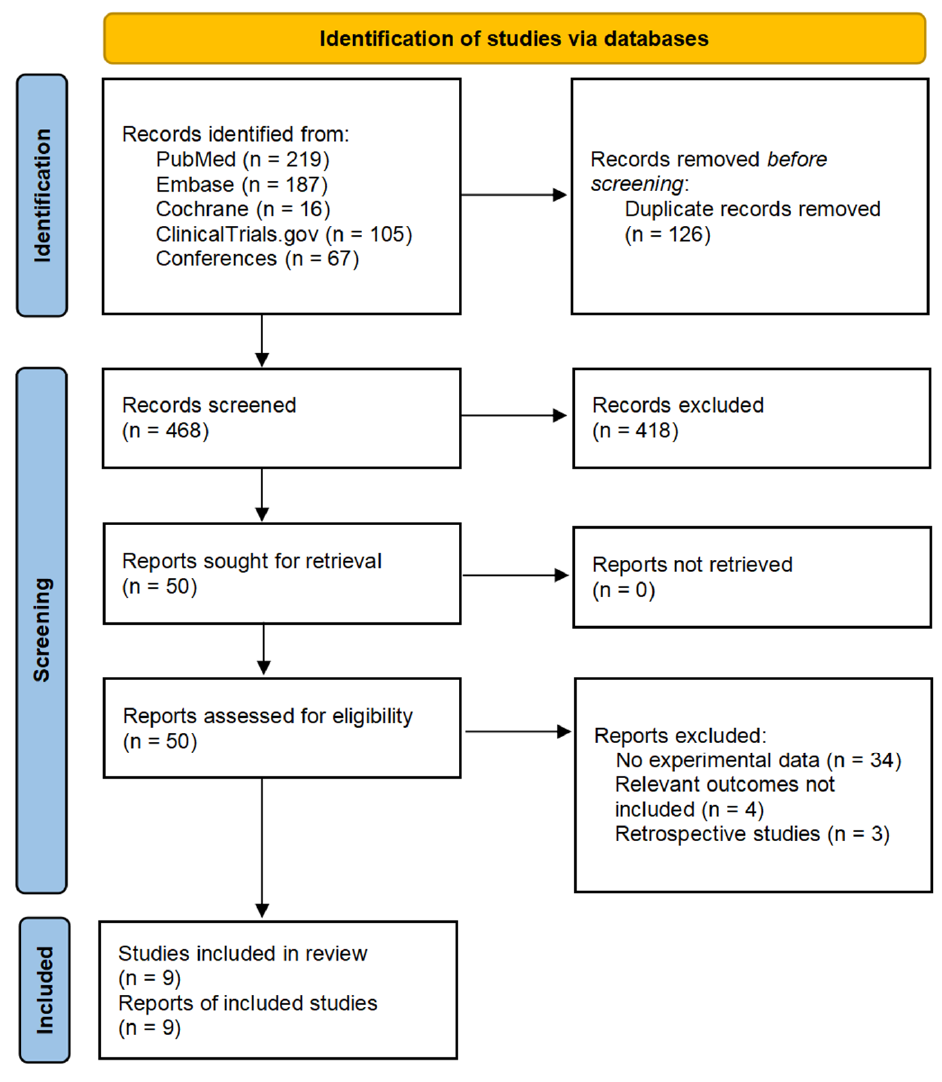
Figure 1. Flowchart of study selection.